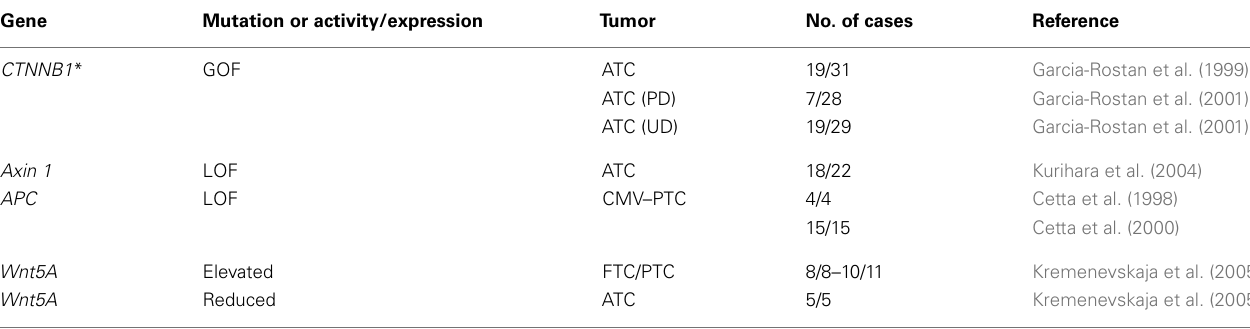
Table 2 | Events linked with aberrant activation ofWnt signaling in thyroid cancer.